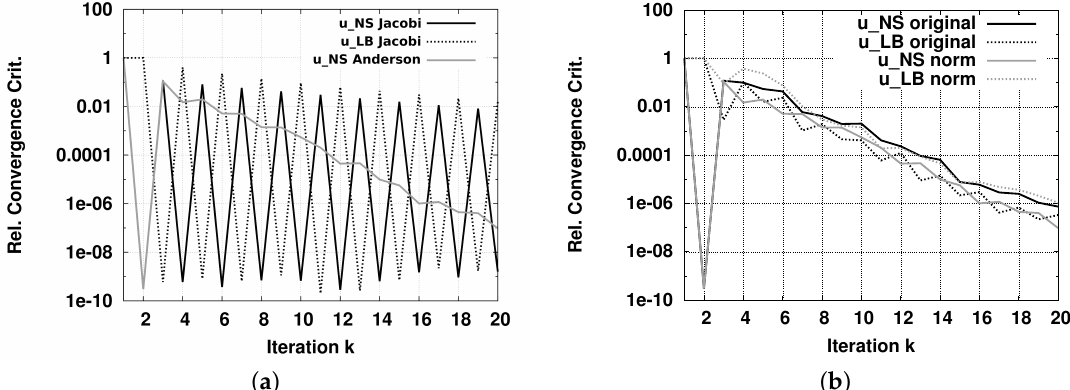
Figure 10. ( a ) Relative convergence criterion of the simple parallel (Jacobi-type) coupling scheme compared to the Anderson acceleration scheme (normalized, primary: u NS ( b ) Relative convergence criterion of the Anderson acceleration scheme. Normalized coupling variables are compared to the original values (primary: u NS